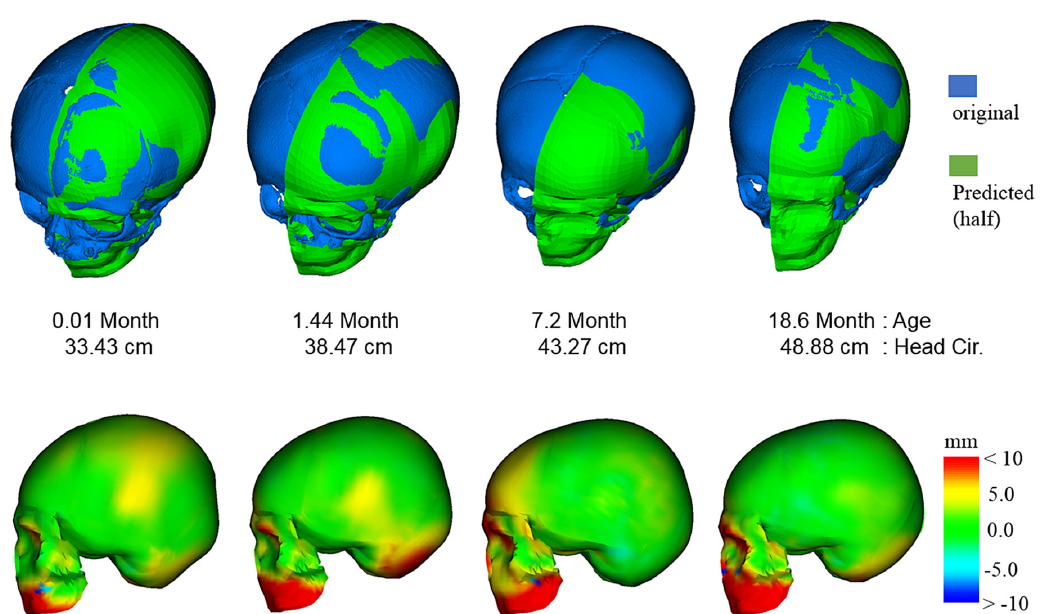
Fig 5. Comparison between model predicted skull geometry and segmented CT